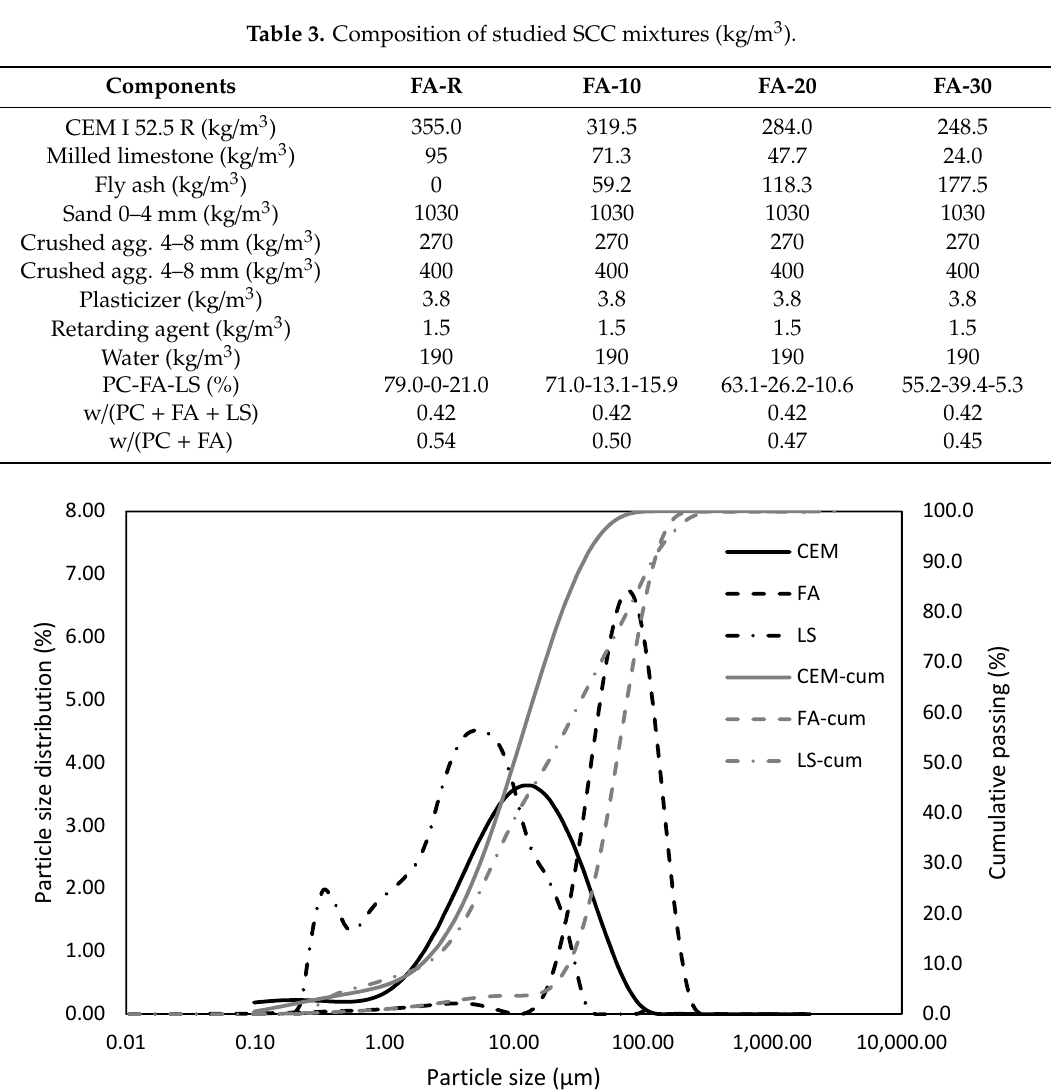
Figure 2. Particle size distribution of used binder components.